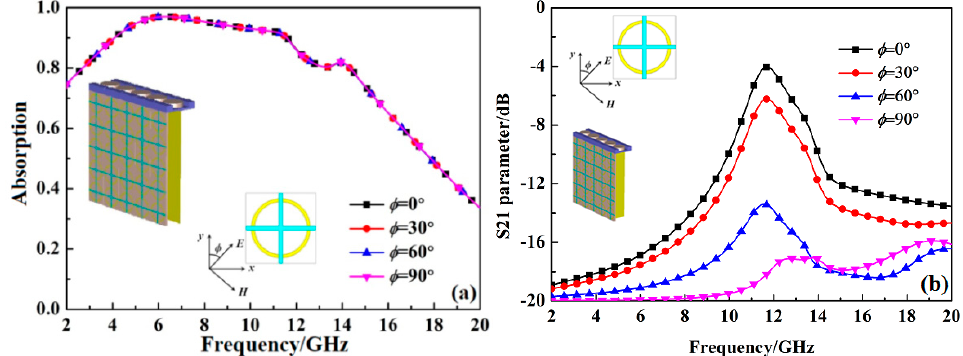
Figure 7. The absorption and transmission coefficient at different polarization angles, ( a ) the absorp- tion, ( b ) the transmission coefficient.